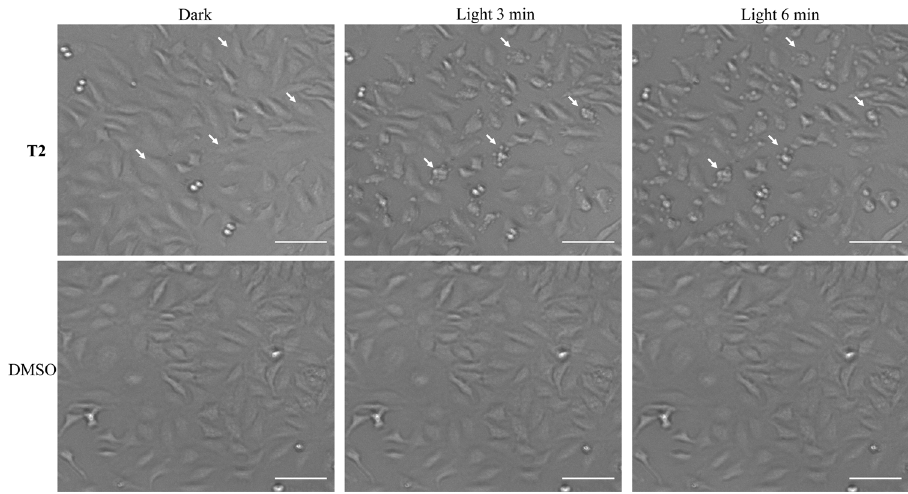
Fig. 7 Light-induced cancer cell death. Time-lapse experiments of live HeLa cells. Upper panel: light-induced morphological changes of T2 -treated (1 μ M) cells after 0, 3, and 6 min of blue light irradiation. Lower panel: Control experiments performed with DMSO-treated HeLa cells. White arrows indicate different cells and how their morphology changes during the time-lapse. Scale bar = 100 μ